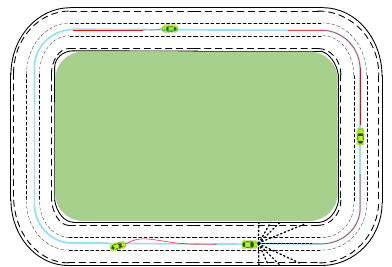
Figure 2. Virtual environment abstract model.